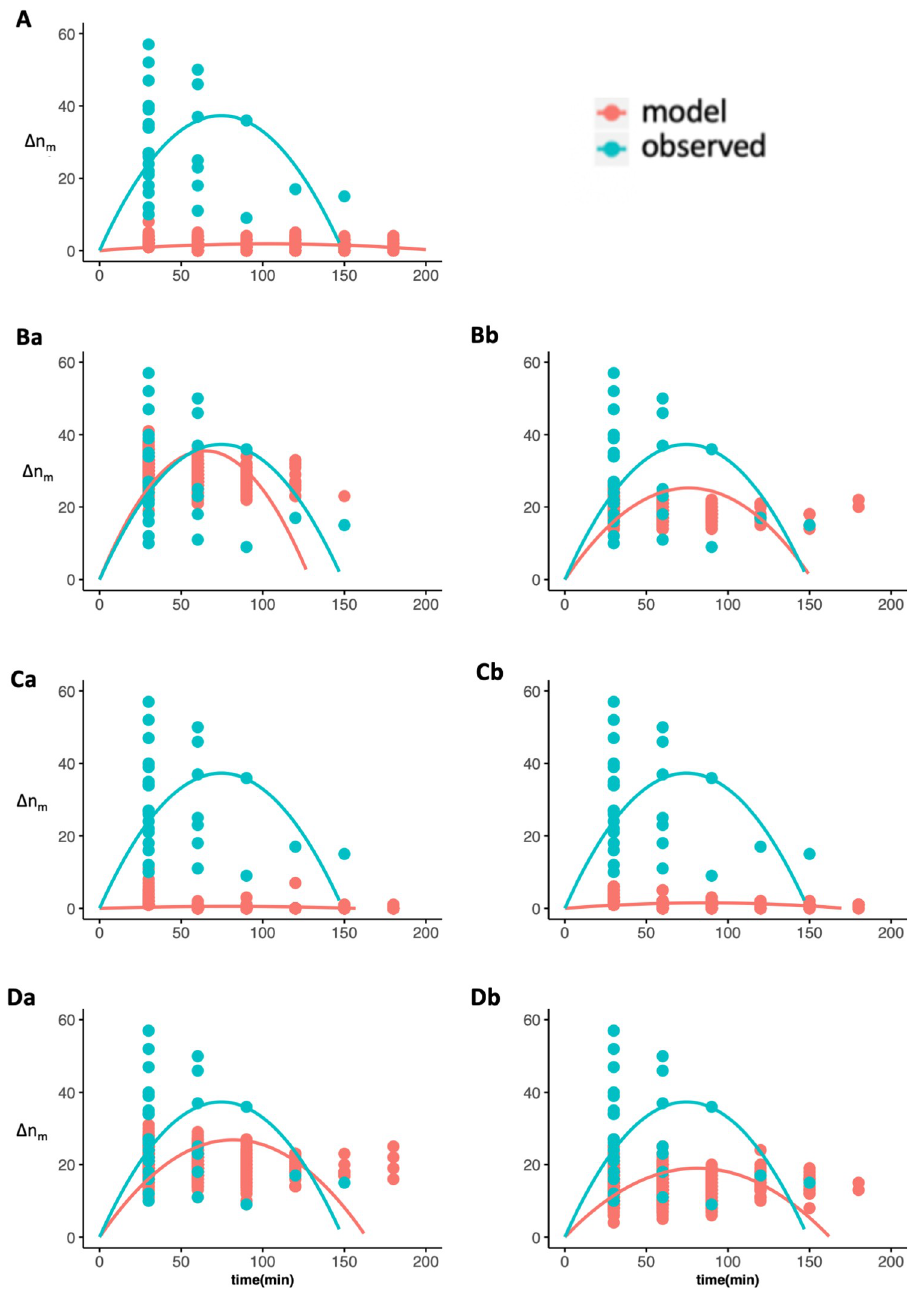
Fig 6. The change in the number of resting individuals in P r:m . Same as Fig 5. number of herd members in that state (number R for state r and number M for state m). To test this hypothesis, a mimetic coefficient C was added in the independent model, which indi- cated the strength of the collective process.